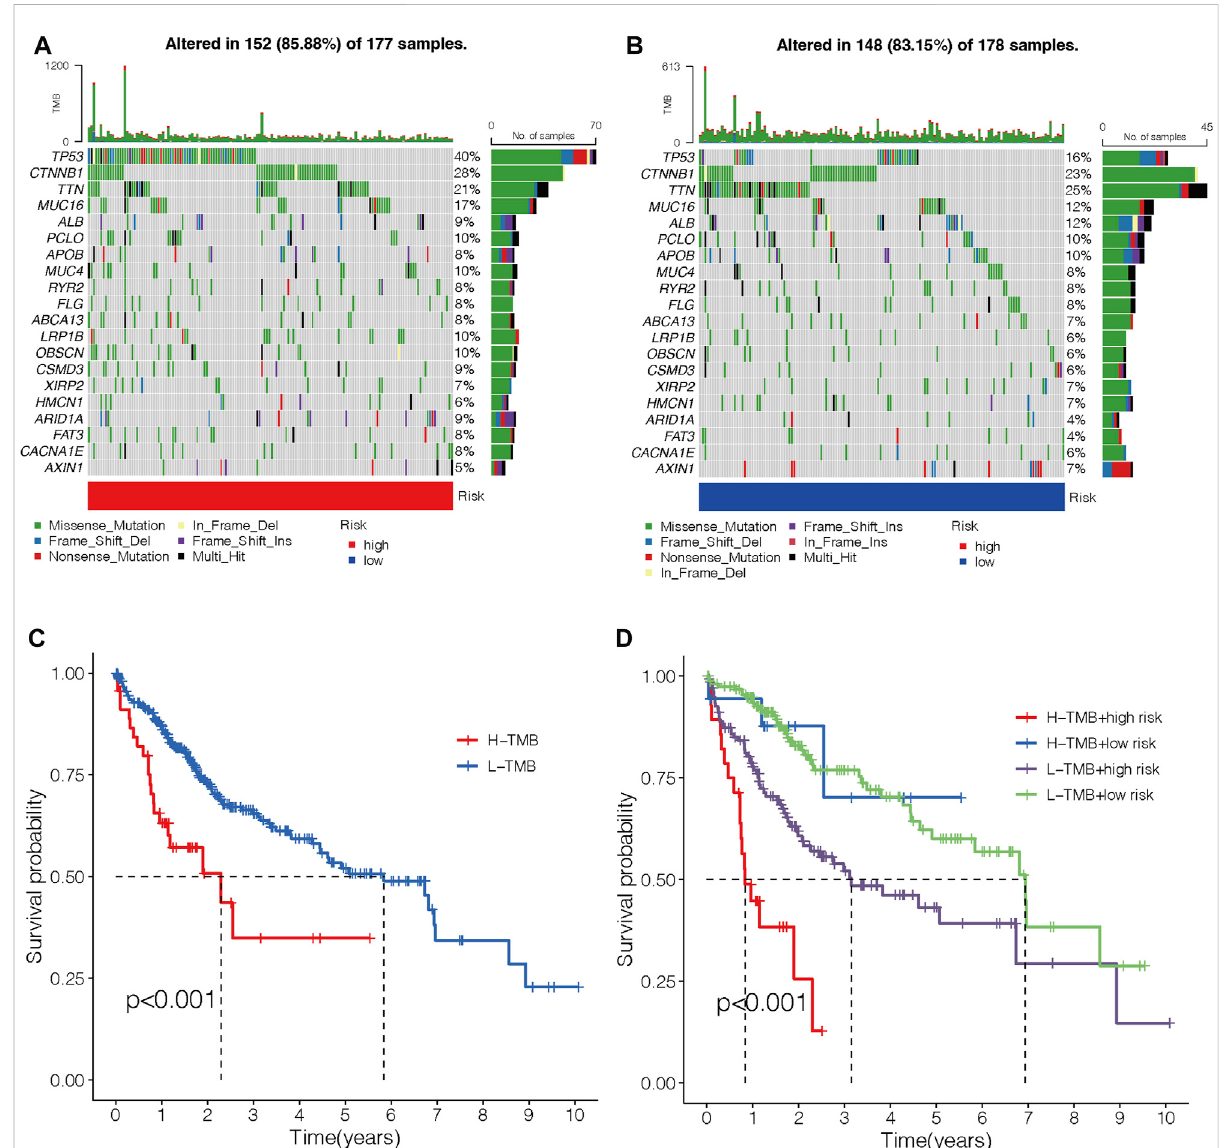
FIGURE 12 CorrelationsbetweentheriskmodelandTMB. (A – B) Waterfalldiagramshowsthetop20mutatedgenesinthehigh- (A) andlow-riskgroups (B) . (C) OS curves for high- and low-TMB sets. (D) OS curves for patients are divided into both TMB and risk scores. TMB, tumor mutation burden. OS, overall